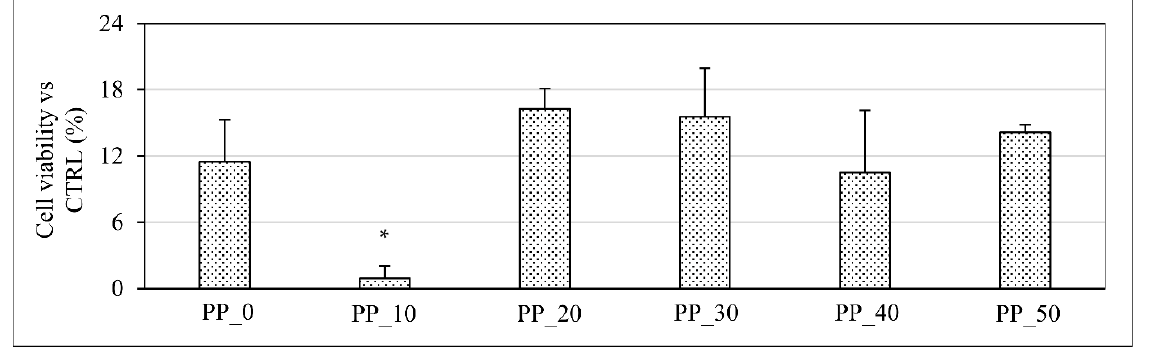
PP_10, PP_20, PP_30, PP_40, PP_50) at 2 h of cell culture to quantitatively evaluate the effect of blend